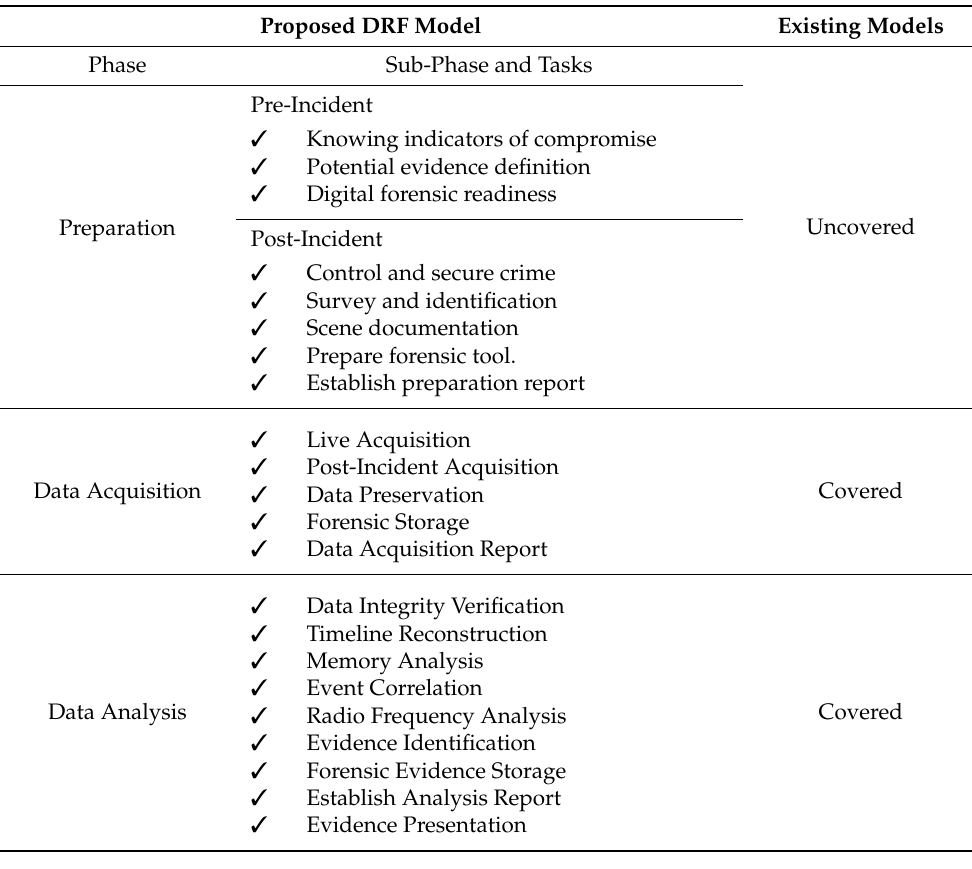
Table 3. Comparison of the proposed DRF model with existing DRF